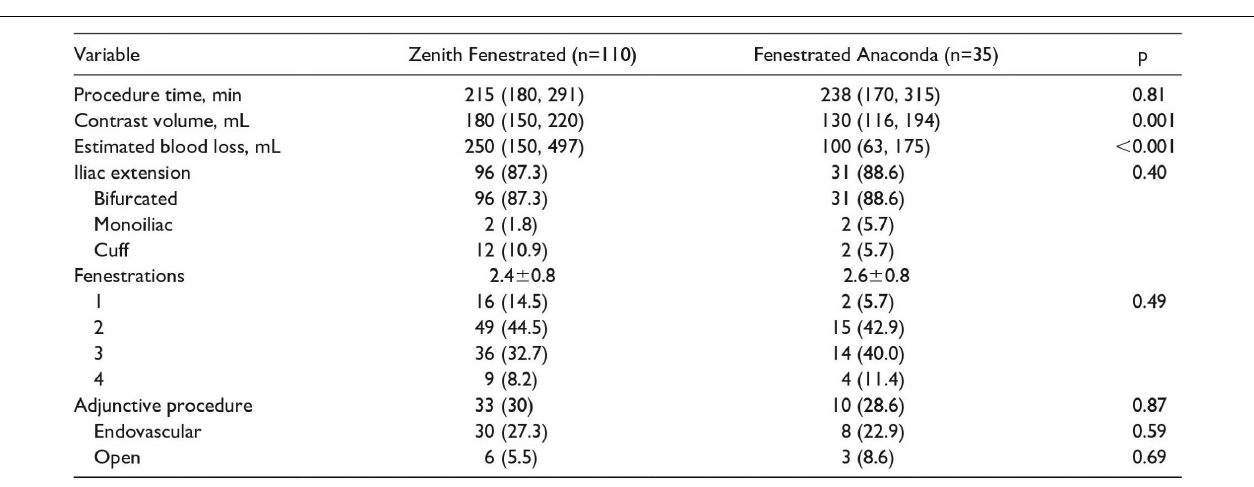
FIGURE 8 | Procedural details of FA and ZP endografts implantations. Reproduced from de Niet et al. (29).